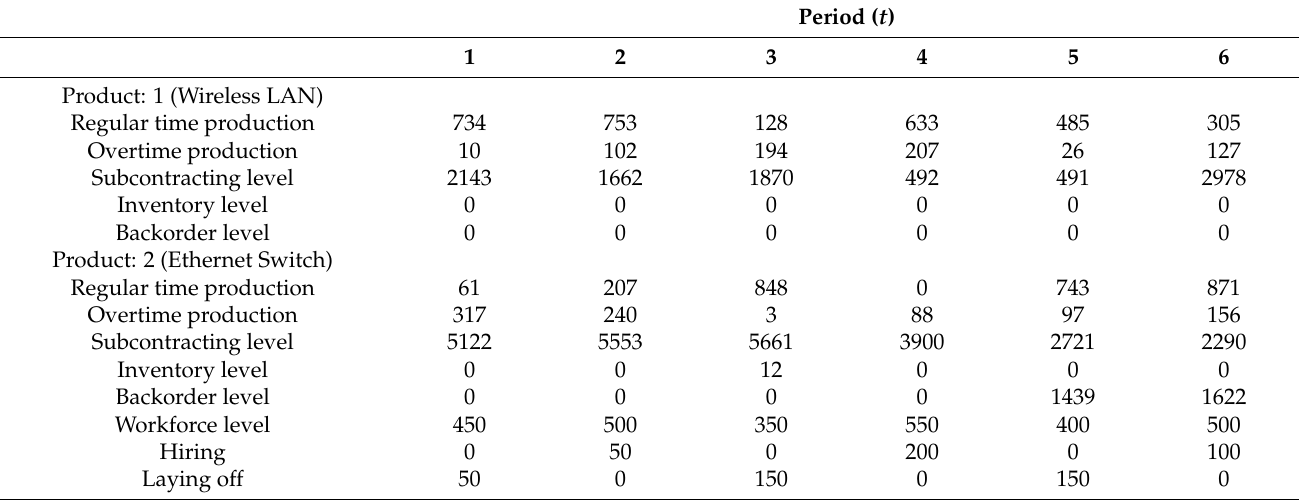
Table 8. Compromise Solution for the Production